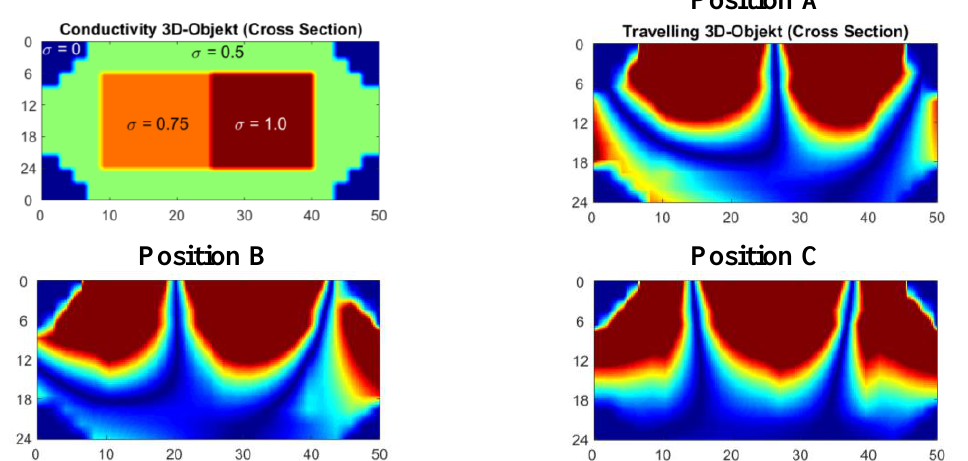
Figure A5. Calculated eddy current distribution in the horizontal middle plane of a more elliptical and inhomogeneous conducting volume, fairly related to a thoracic cross-section. Eddy current fields are still similar to Figure 11, and a Φ-mode establishes in position C.